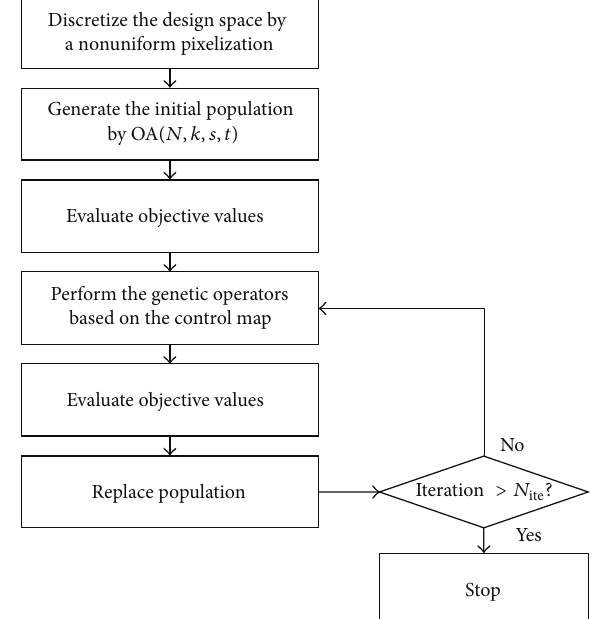
Figure 8: Flowchart of the building-block favoring